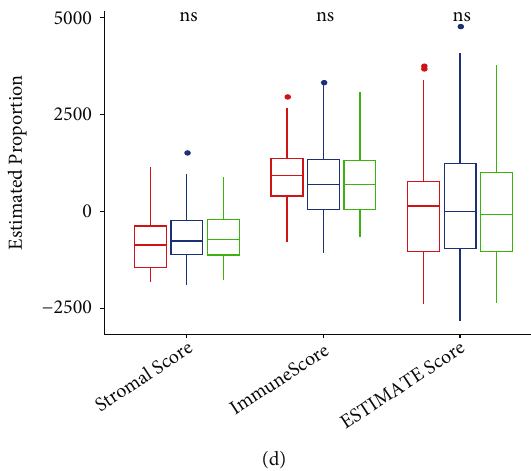
Figure 3: Evaluation of immune cell proportions for three clusters in two datasets. (a) Immune cell score di ff erence between three clusters in the TCGA-LIHC cohort. (b) ESTIMATE immune in fi ltration di ff erence between three clusters in the TCGA-LIHC cohort. (c) Immune cell score di ff erence between three clusters in the ICGC-LIHC cohort. (d) ESTIMATE immune in fi ltration di ff erence between three clusters in the ICGC-LIHC cohort. *P < 0.05; **P < 0.01; ***P <